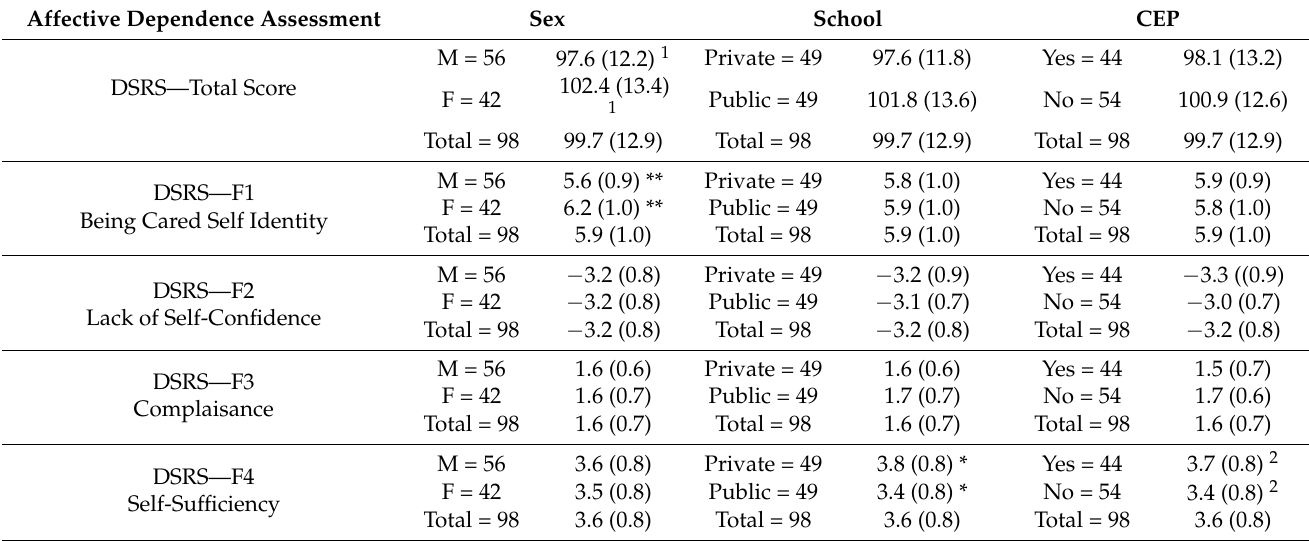
Table 6. Mean and standard deviation of the variables used to assess Affective Dependence (DSRS) and their differences by sex, school and participation in Coding Educative